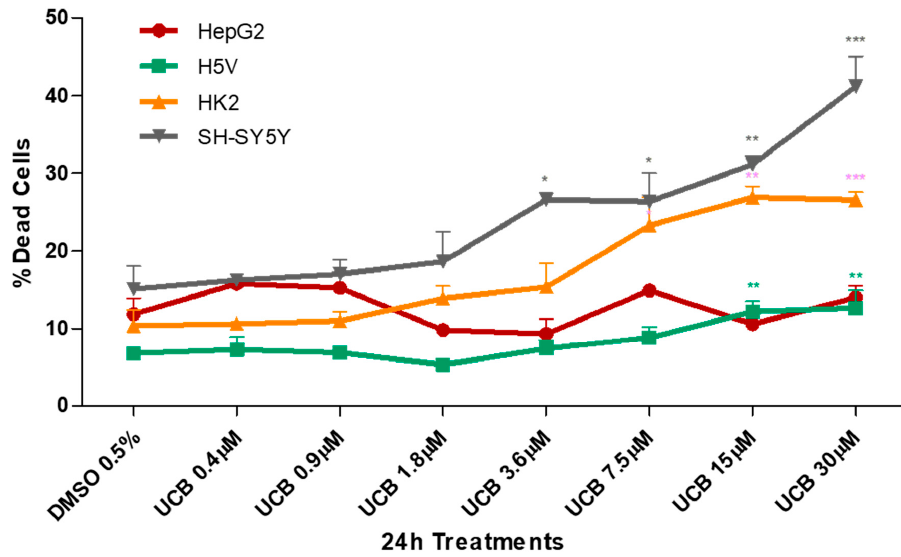
Figure 1. The effect of unconjugated bilirubin (UCB) treatment on cell viability. The cell lines were exposed to the increasing UCB concentration (from 0.4 to 30 µM in the presence of 30 µM BSA) or 0.5% DMSO for 24 h and then treated with propidium iodide (PI). The percentage of dead cells was calculated as the proportion of fluorescence intensity of dead cells to that of total cells. Data are expressed as mean ± SD of at least four independent experiments. * p < 0.05, ** p < 0.01, *** p < 0.001). UCB cytotoxicity showed three different levels of susceptibility among the cell lines. HepG2 cell line was less sensitive, while the neuronal cells appeared the most sensitive. HK2 and H5V showed an intermediate dose-dependent cytotoxicity behavior. The first significant increase in dead cells was detected at UCB concentrations of 3.6 µM for SH-SY5Y, 7.5 µM for HK2 and 15 µM for H5V. No changes were observed in HepG2.